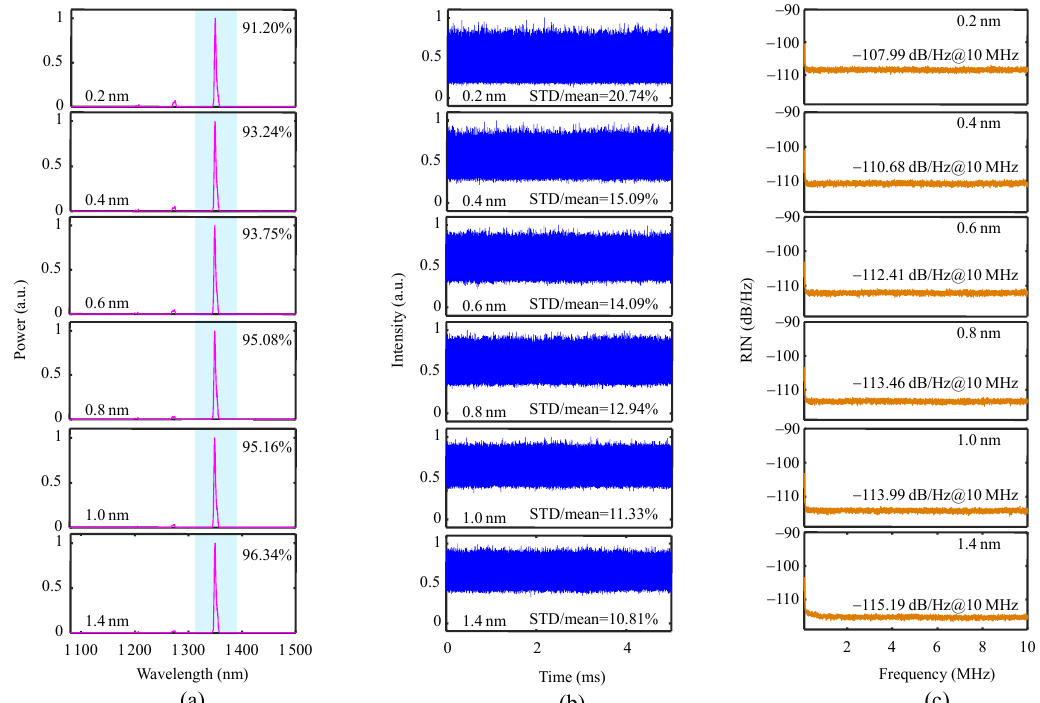
Fig. 6 Properties of the 4th-order random Raman lasing pumped by YRFL with different point reflector’s bandwidths: (a) spectra evolution, (b) time domain traces, and (c)